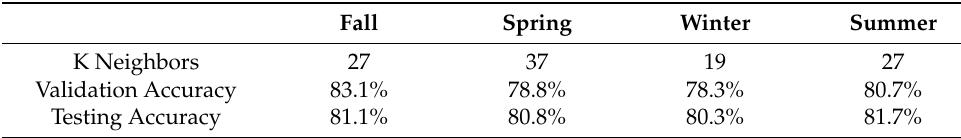
Table 2. Final KNN model